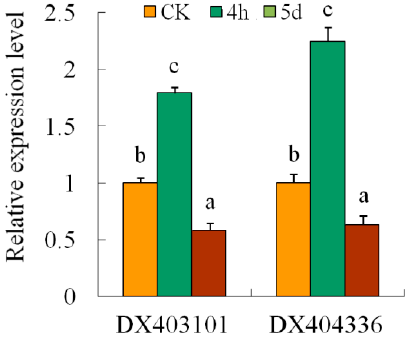
Figure 5. Relative expression levels of two retrotransposons under salt stress. The different letters of each retrotransposons present on the columns indicate significant differences at p <0.05 among the CK, 4-h and 5-d samples. Error bars represent standard error of the mean.